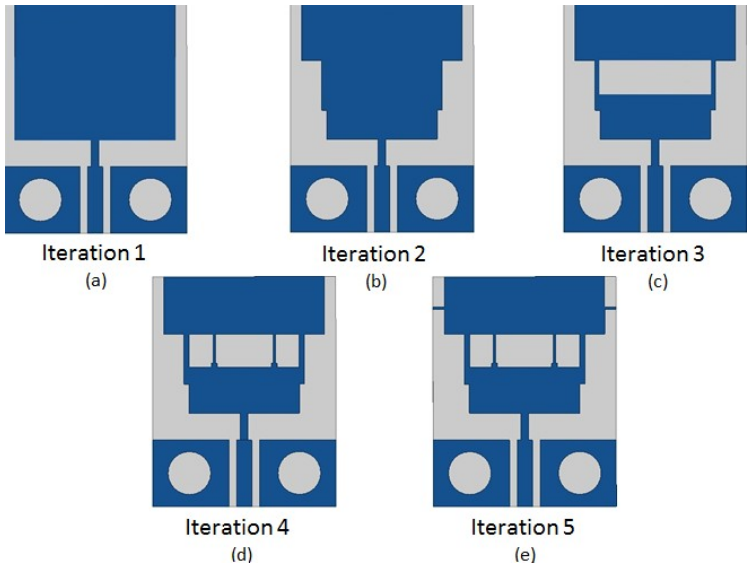
Figure 1. Evolution of the patch structure: ( a ) Rectangular Patch Antenna applied parasitic element with circular slot, ( b ) converted patch to monopole, ( c ) Install rectangular slot at the center, ( d ) add symmetrical T shapes in the rectangular slot, ( e ) add stubs at left & right sides of the patch.